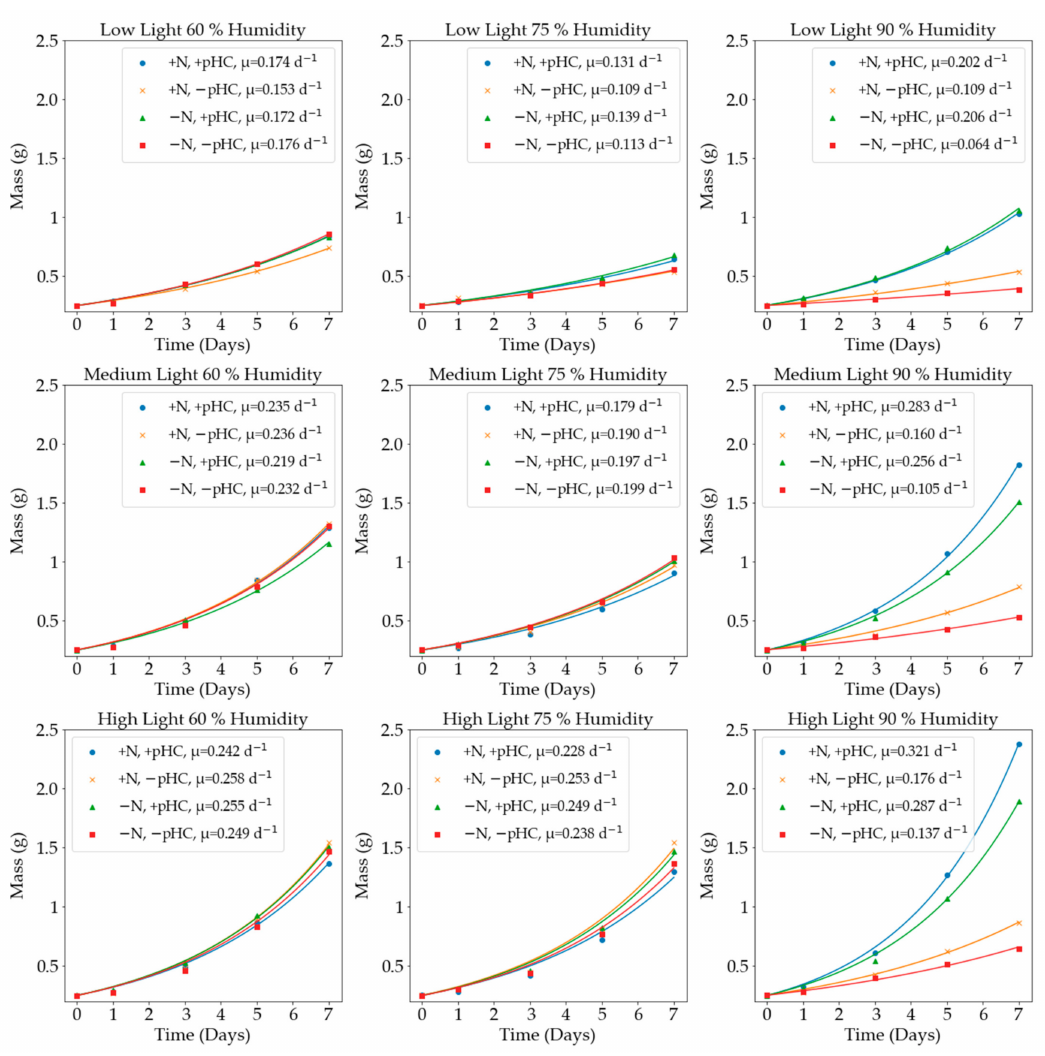
Figure 4. A comparison between the experiments for the presence (+N) versus absence ( − N) of nitrogen, pH control (+pHC) versus non-pH control ( − pHC), different light intensities (low: 5000 lx, medium: 10,000 lx, and high: 20,000 lx), and different humidity values (60%, 75%, and 90%). The average weight values are plotted, along with the optimised growth curve and the growth